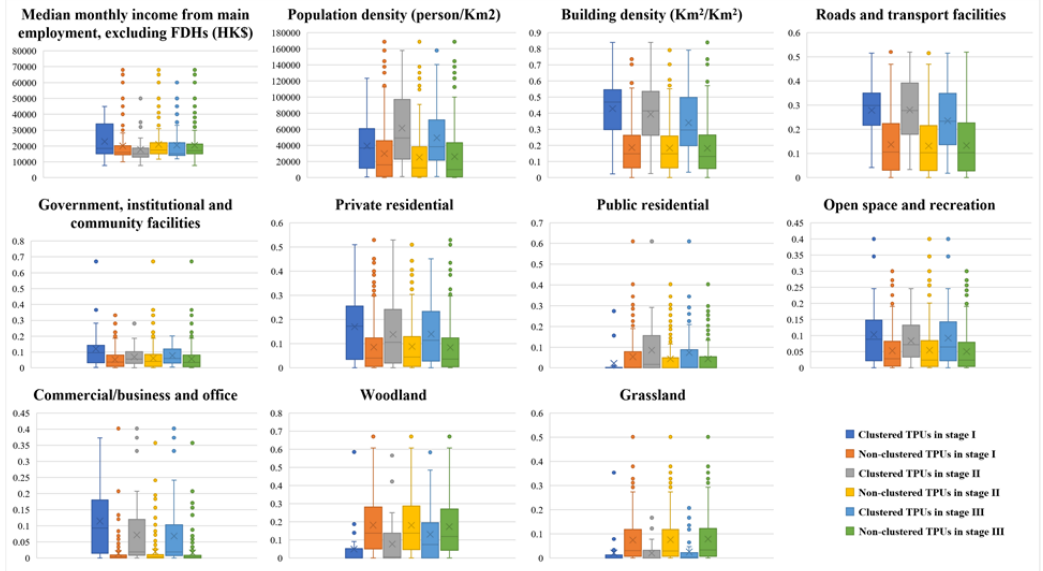
Figure 13. Features ’ distribution of clustered TPUs and non-clustered TPUs of COVID-19 transmis- Figure 13. Features’ distribution of clustered TPUs and non-clustered TPUs of COVID-19 transmission sion in non-residential locations at different stages of the pandemic in Hong Kong. in non-residential locations at different stages of the pandemic in Hong Table 10. Features ’ distribution at different stages of non- residential location (“ p - value” is per- formed as asymptotic two-tailed significance of the Mann – Whitney test) .